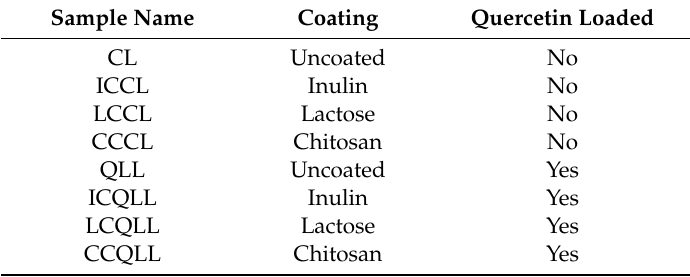
Table 1. Samples identification and description of liposomes. (CL) control liposomes, (QLL) quercetin loaded liposomes, (XCCL) polysaccharide coated control liposomes, and (XCQLL) polysaccharide coated quercetin loaded liposomes. Where X stands for the corresponding polysaccharide (I) inulin, (L) lactose, and (C)